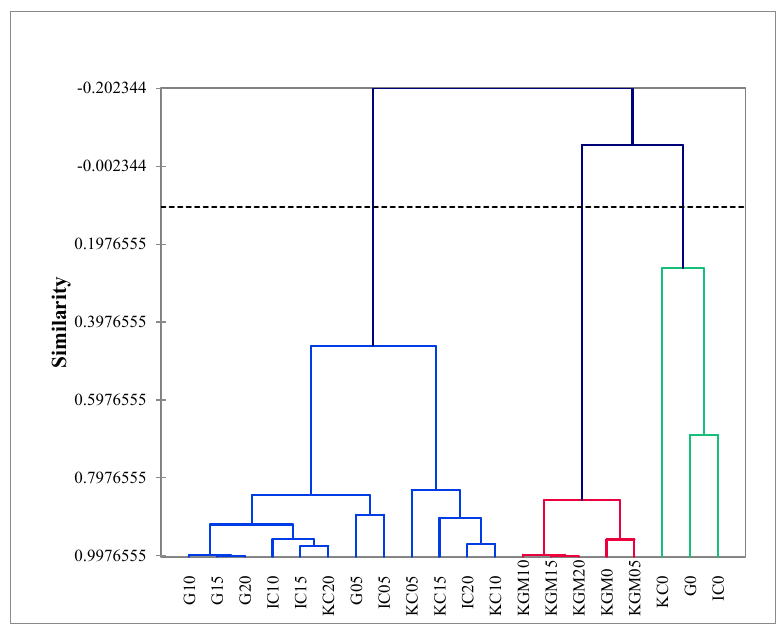
Figure 4. Dendrogram from agglomerative hierarchical cluster analysis (unweighted pair–group average method) of 20 model confectionary gel samples by sensory attributes based on sugar concentration. Similarity based on Pearson correlation coefficient. G = gelatin, IC = ι -carrageenan, KC = κ -carrageenan, KGM = konjac glucomannan.